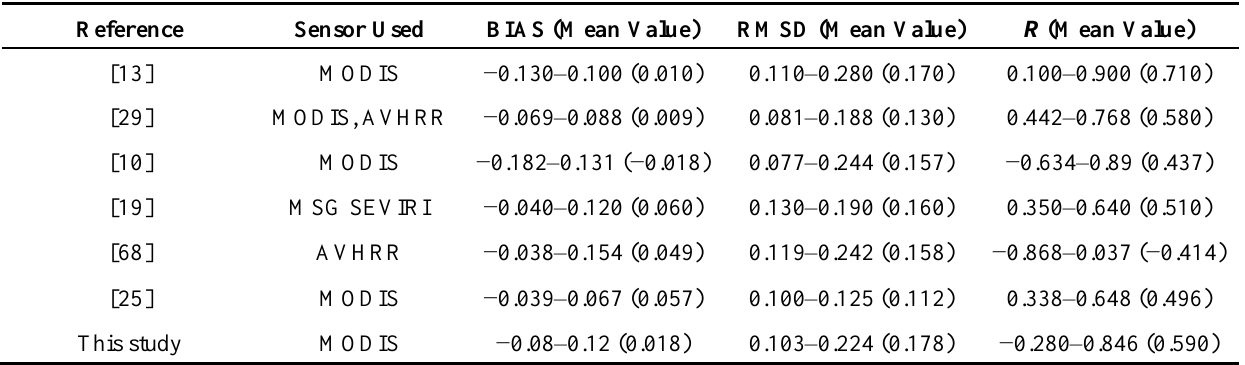
Table 4. Accuracy assessment of the LST/NDVI feature space method used to derive EF in the literature.